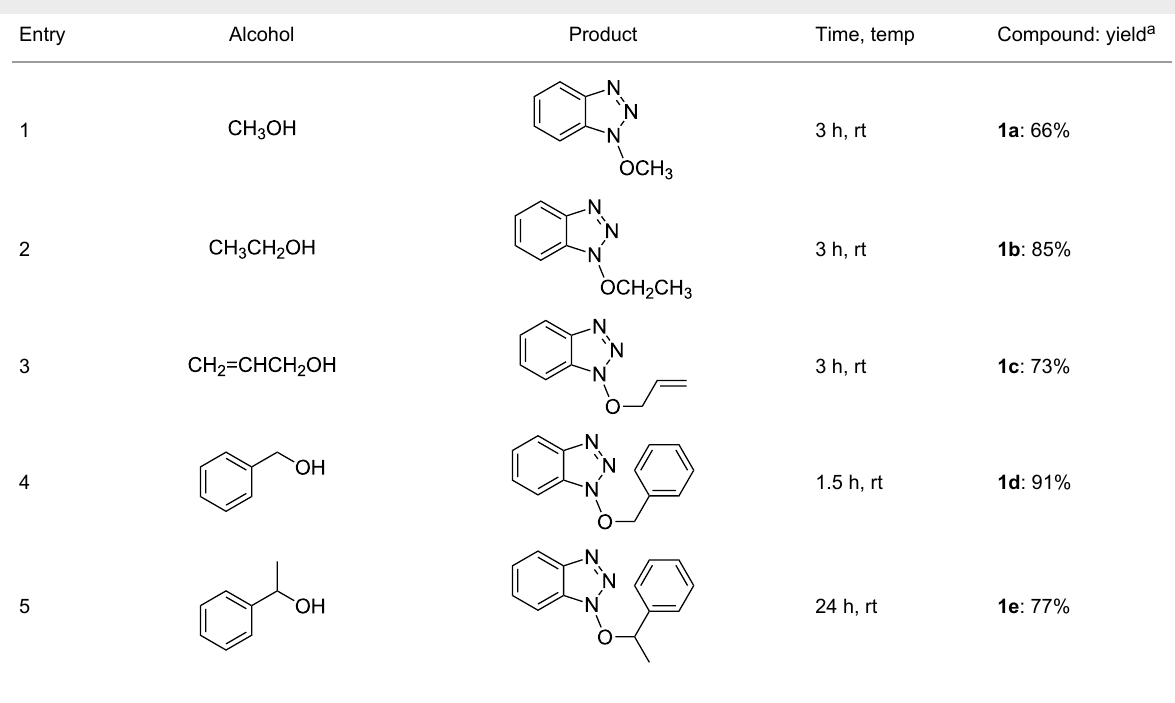
Table 2: Reactions of various alcohols with